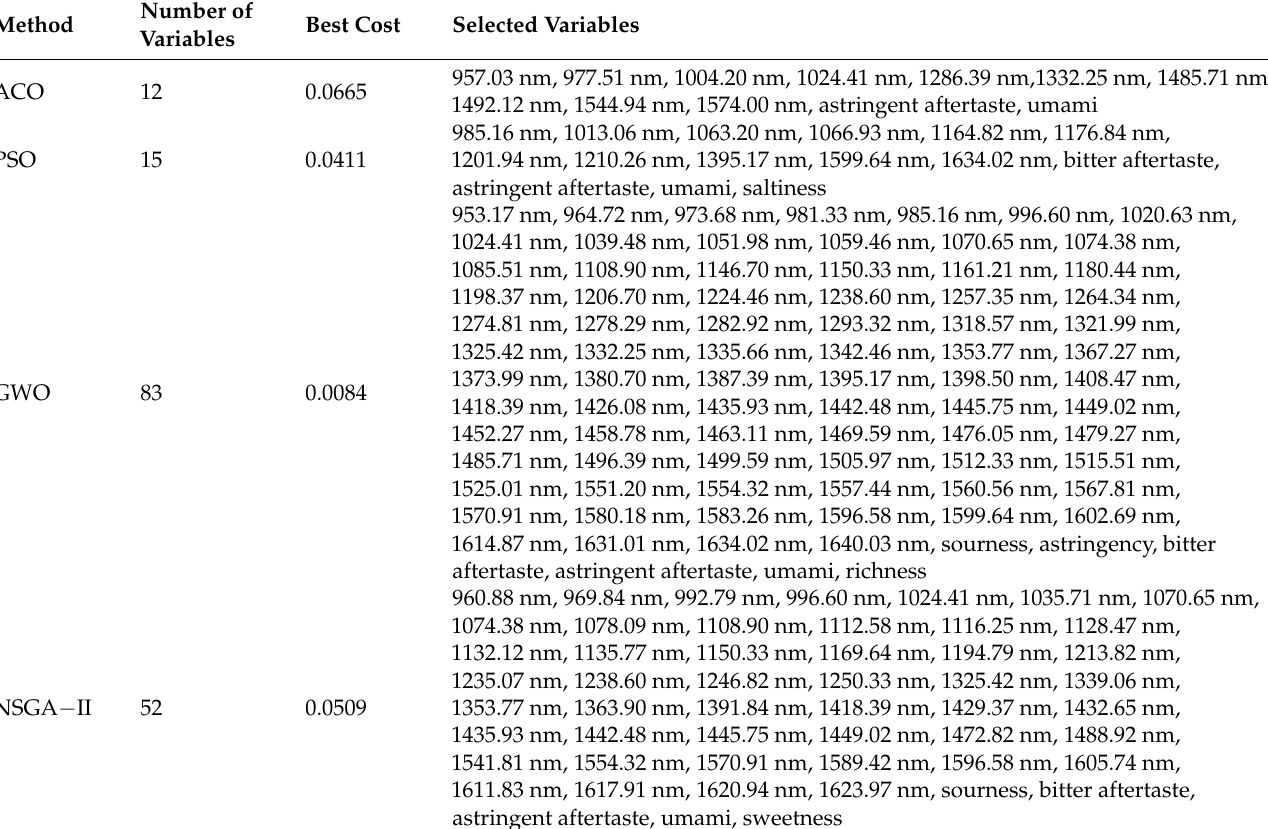
Table 1. Statistical results of different feature variable selection methods within 100